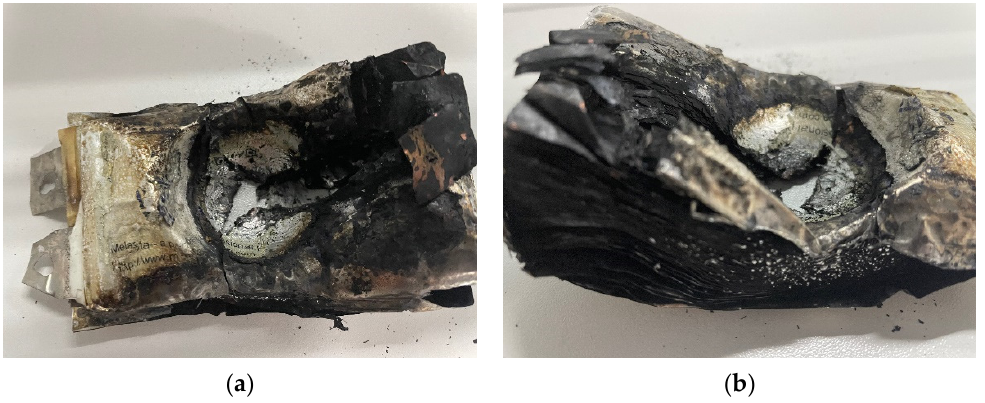
Figure 21. Post-test battery picture. ( a ) Post-test battery; ( b ) Precipitation of metallic substances.